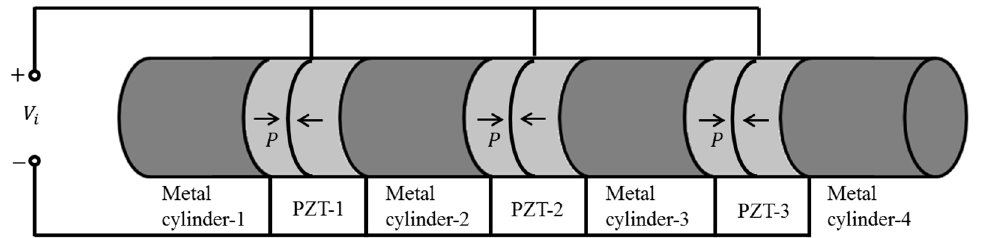
Figure 1. The cascaded piezoelectric ultrasonic transducer with three sets of piezoelectric ceramic stacks.